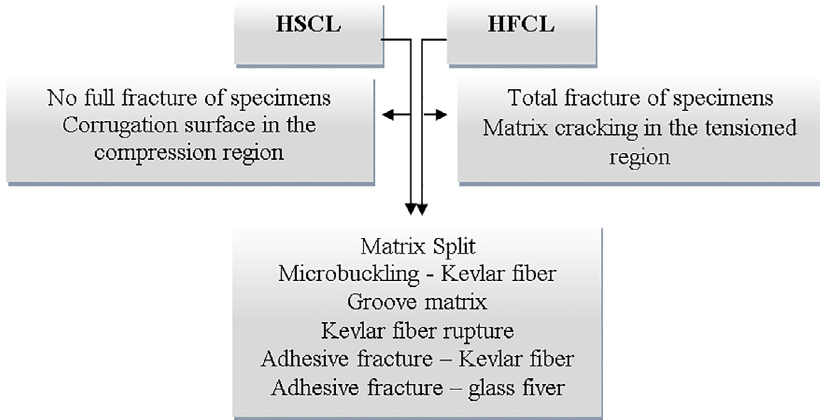
Figure 21. Flowchart: three-point bending test fracture